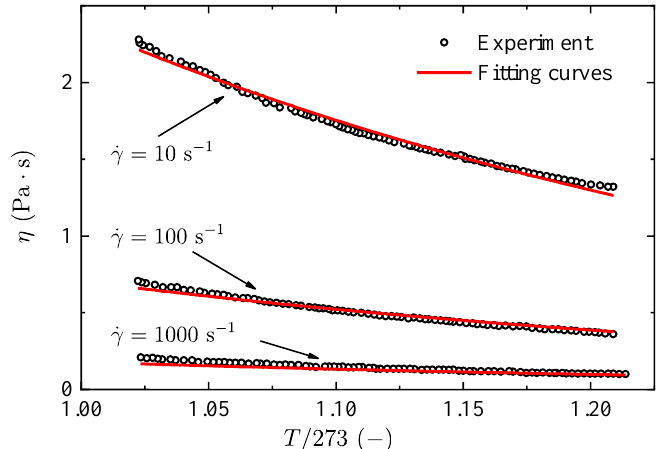
Figure 1. Experimental measurements and the model prediction of the viscosity of the water gel. The experimental data are from Ref. [41].